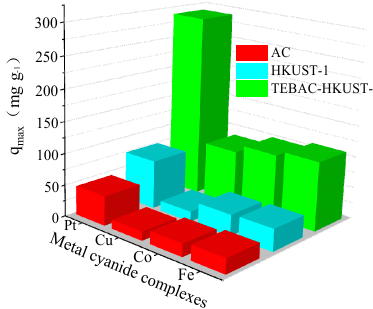
Figure 7. Maximal adsorption capacity for the metal cyanide complexes.